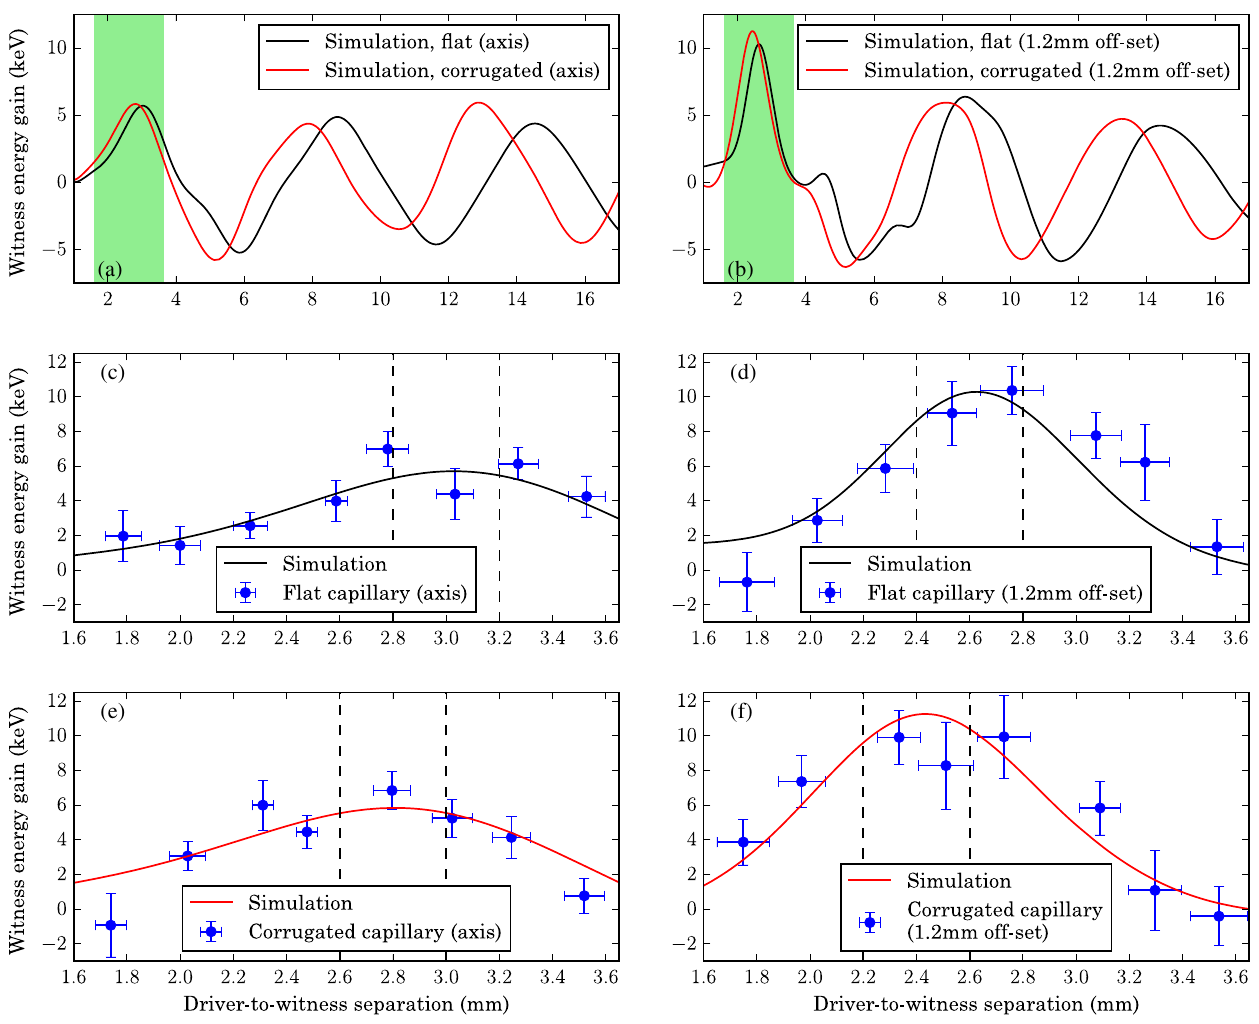
FIG. 7. First three acceleration-deceleration cycles [(a) and (b)], from Fig. 4, and comparison with experimental data for on-axis [(c) and (e)] and 1.2 mm off-axis [(d) and (f)] beam propagation in capillaries.